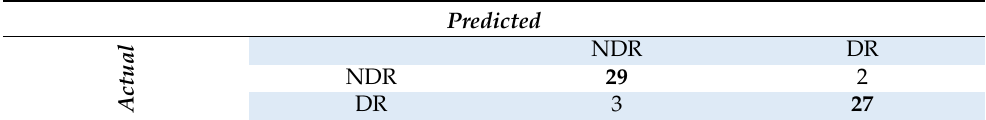
Table 3. Confusion Matrix for two